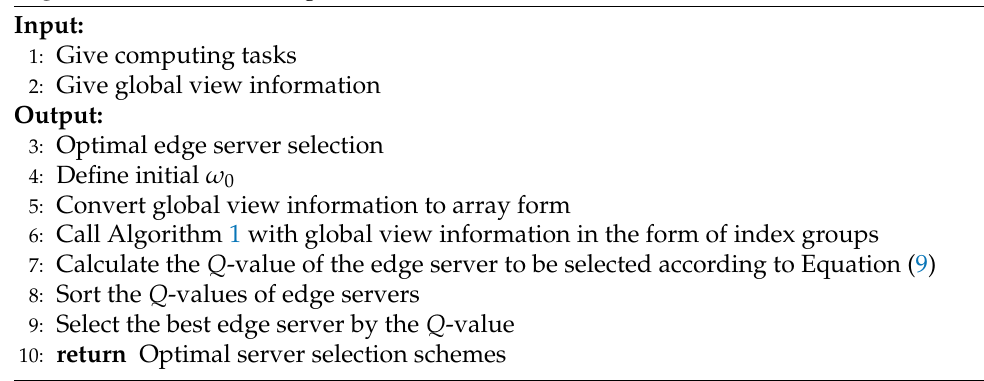
Algorithm 2 RL-SDETA